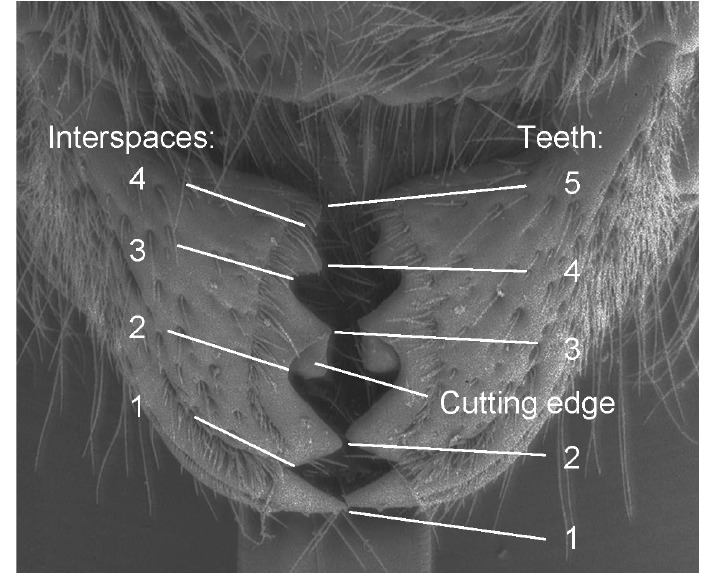
Figure 1. Female mandible of Megachile ( Megachile ) centuncularis ; the white lines and the numbers in- dicate the five teeth (numbers on the right) and the four interspaces (numbers on the left); in this species, there is a partial cutting edge in the second interspace and, in front view, no visible cutting edge in the other interspaces. Picture by Andreas Müller (Müller et al.